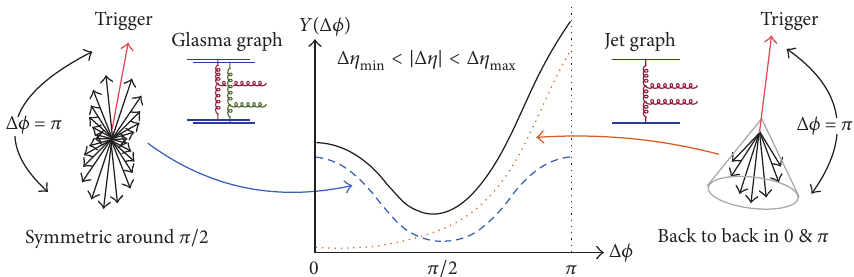
Figure 4: A cartoon showing the contributions of dijet and Glasma graphs in two-particle correlation function 𝑌(Δ𝜙) integrated over a broad range of |Δ𝜂| . This is a slightly modified version of the figure from